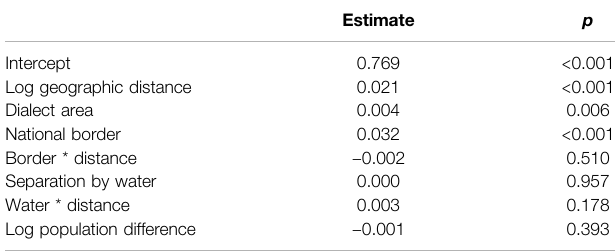
TABLE8| Multipleregressionoverdistancematrices(MRM)resultsforthe Human body domain.